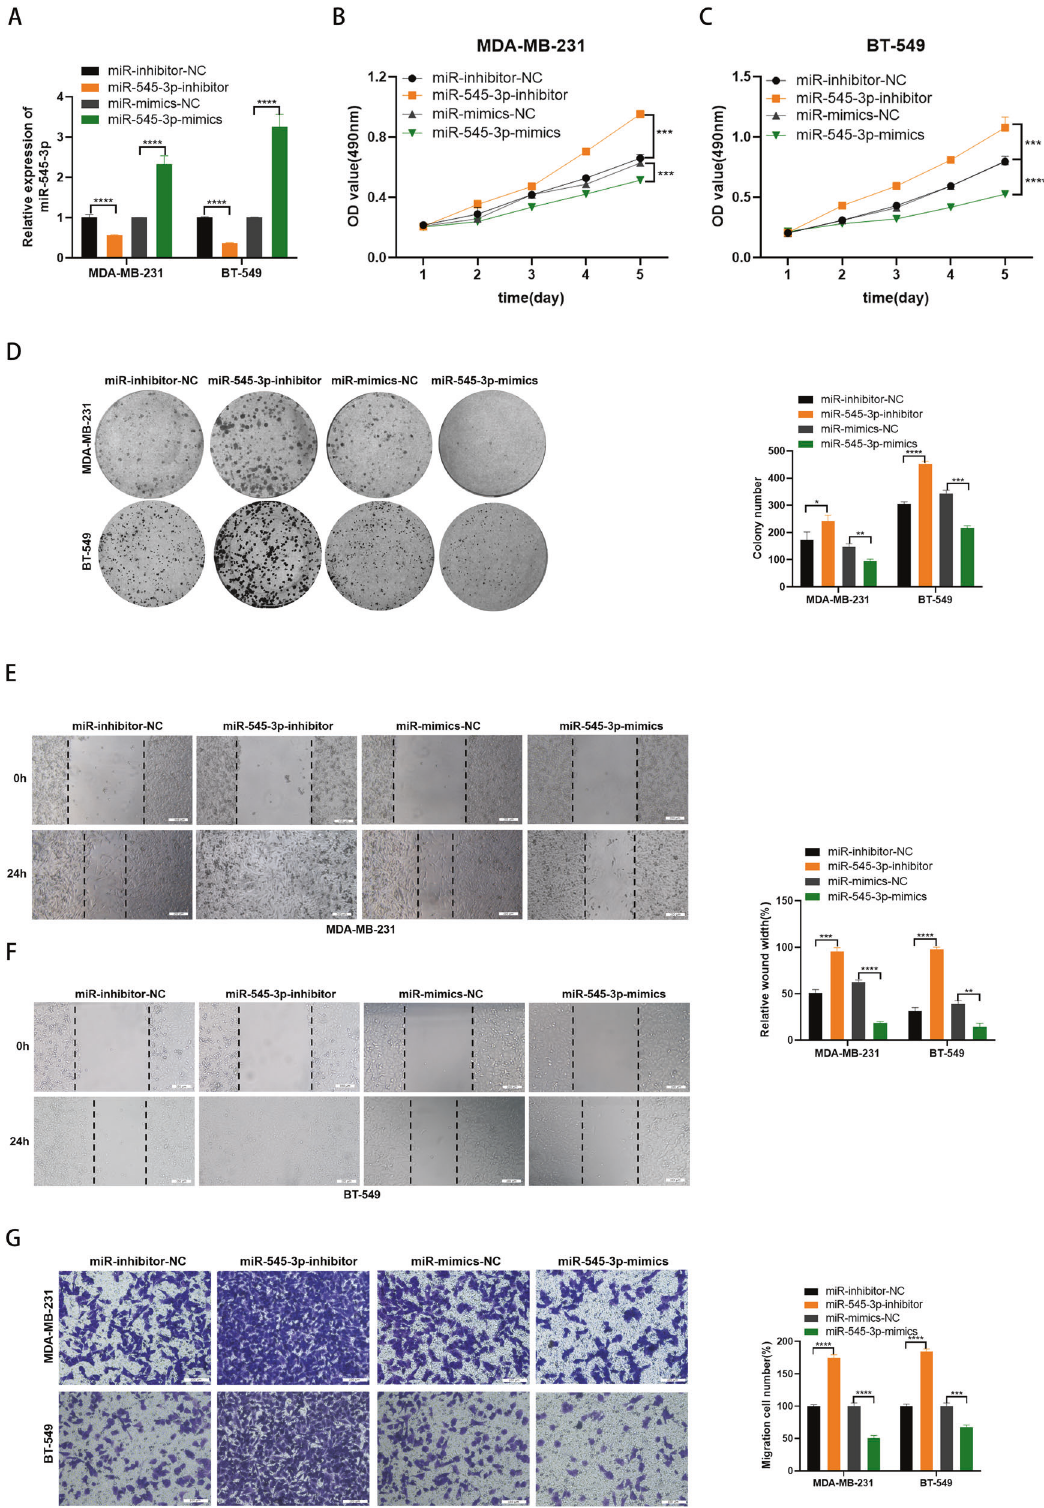
Fig. 4 MiR-545-3p served as a tumor suppressor in TNBC cells. A Expression of circPRKCI was con fi rmed by qRT-PCR in TNBC cells transfected with miR-545-3p-inhibitor or miR-545-3p-mimics. B , C Effect of miR-545-3p on proliferation in TNBC cells by MTT assay. D Effect of miR-545-3p on proliferation in TNBC cells by colony formation assay. E , F Effect of miR-545-3p on migration in TNBC cells by wound healing assay. G Effect of miR-545-3p on migration in TNBC cells by cell migration assay. * p < 0.05, ** p < 0.01,*** p < 0.001,**** p < 0.0001.